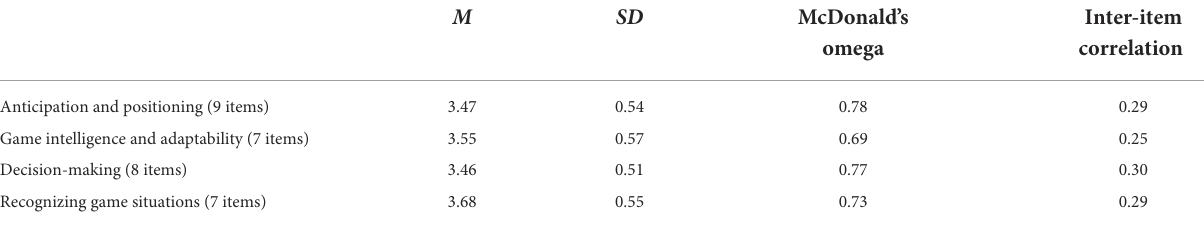
TABLE 2 Descriptive statistics, McDonald’s omega, and average inter-item correlation coefficients of subscales of the TSQT ( n = 233).